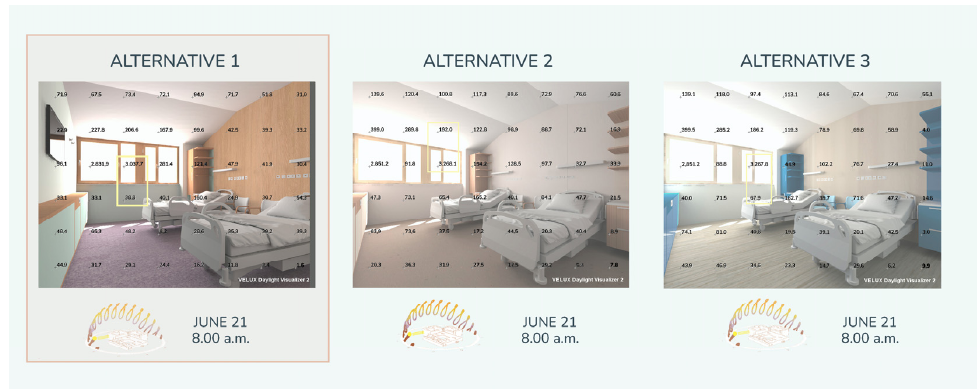
Figure 17. Alternative proposals for the design of finishing materials in room